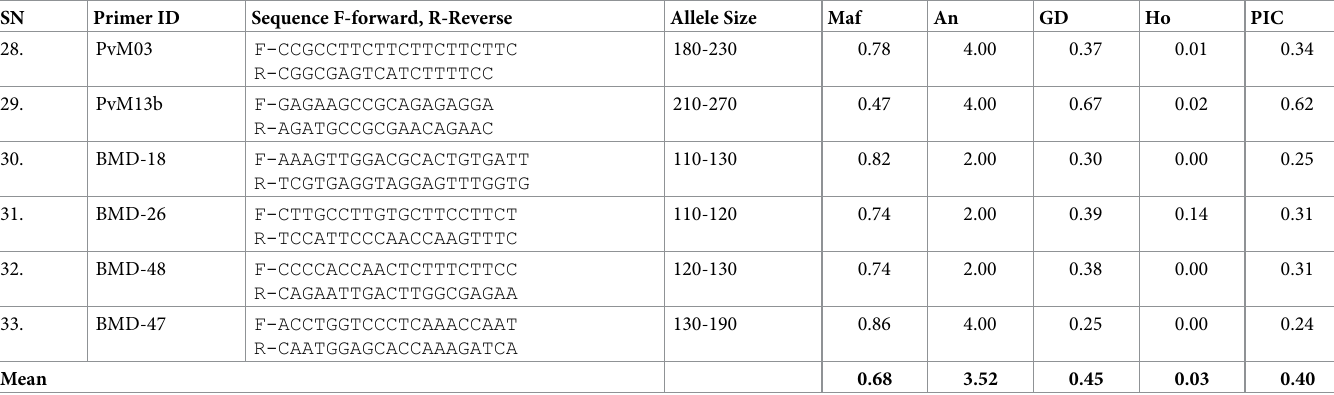
population groups, while the remaining 14 (14.89%) were designated as admixed forms with varying levels of memberships shared among the five genetic populations. The population I contained 22 accessions with 19 pure and 3 admixtures. The population II comprised of 12 accessions with 11 pure and 1 admixture forms. The population III comprised of 17 pure and